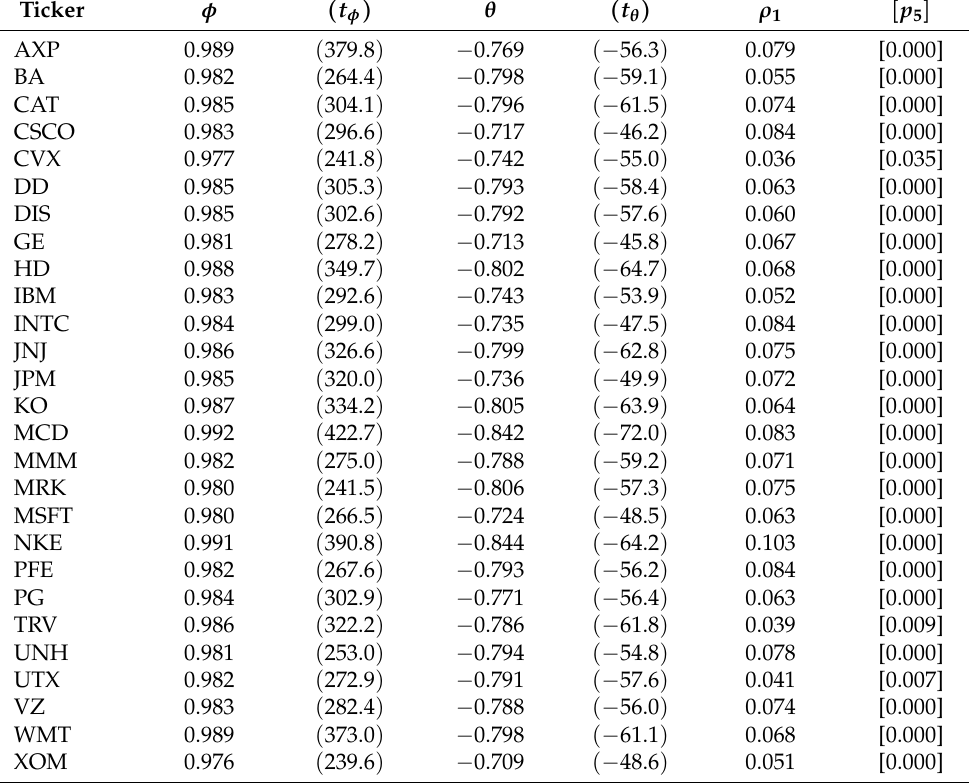
Table A5. ARMA(1,1) estimates for daily log realized quarticity. The ARMA(1,1) model